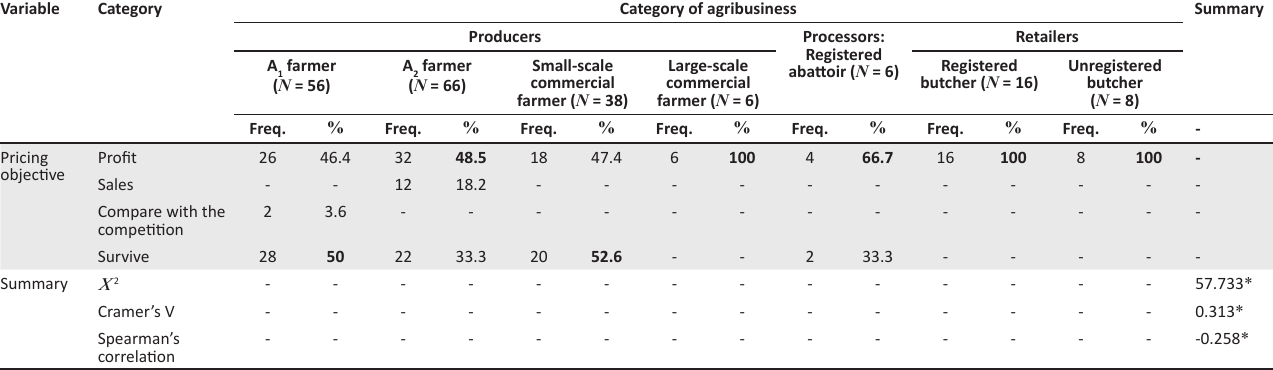
TABLE 4: Cross-tabulation of pricing objectives and category of agribusiness. Variable Category